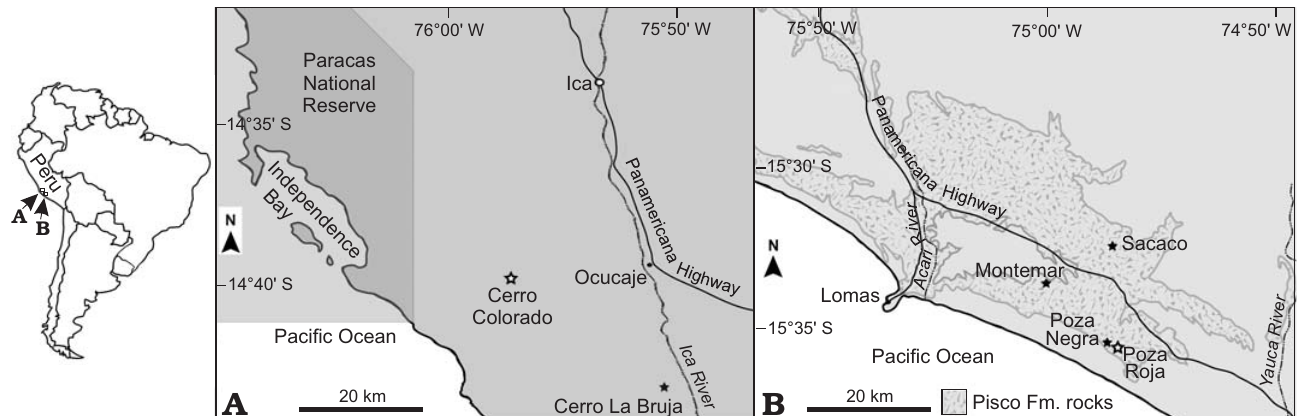
Fig. 1. Maps of the Ocucaje ( A ) and Sacaco ( B , modified from Brand 2001) areas, southestern Peru, indicating the type localities of fossil sulids described in this